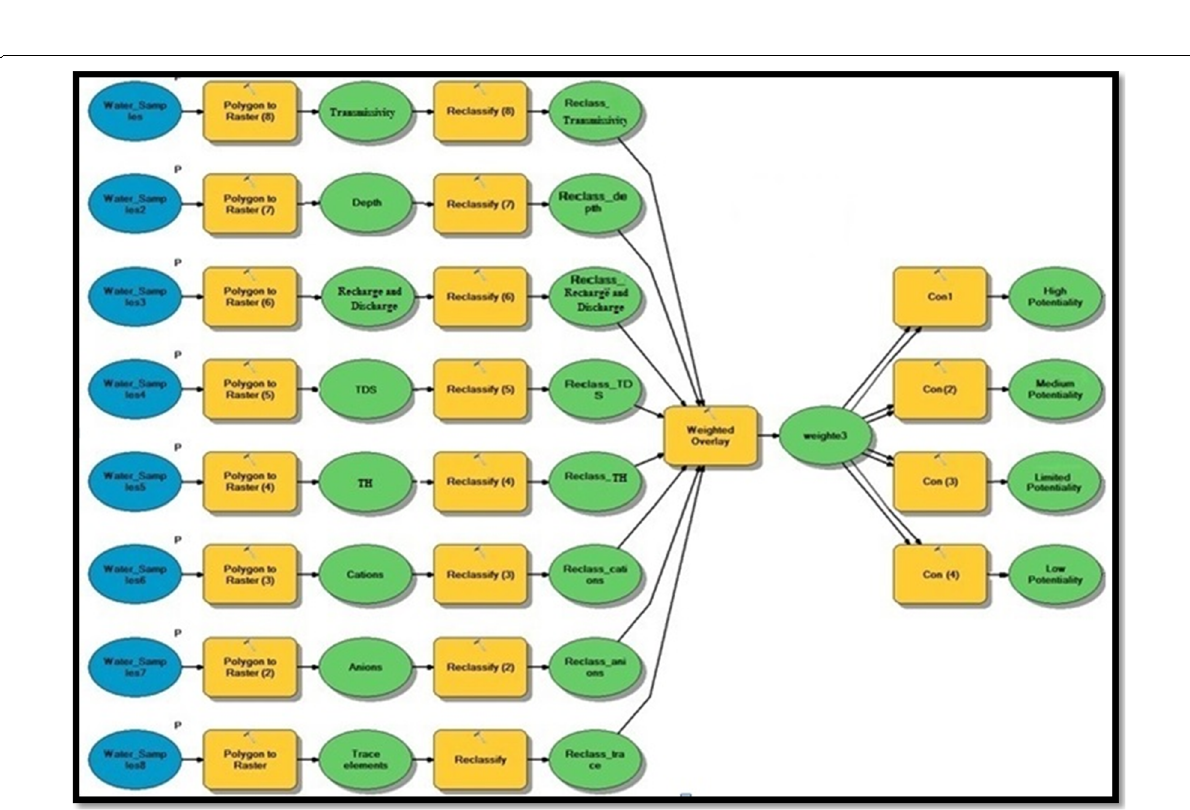
Fig. 16 Water recourses potentiality model flow chart for drinking